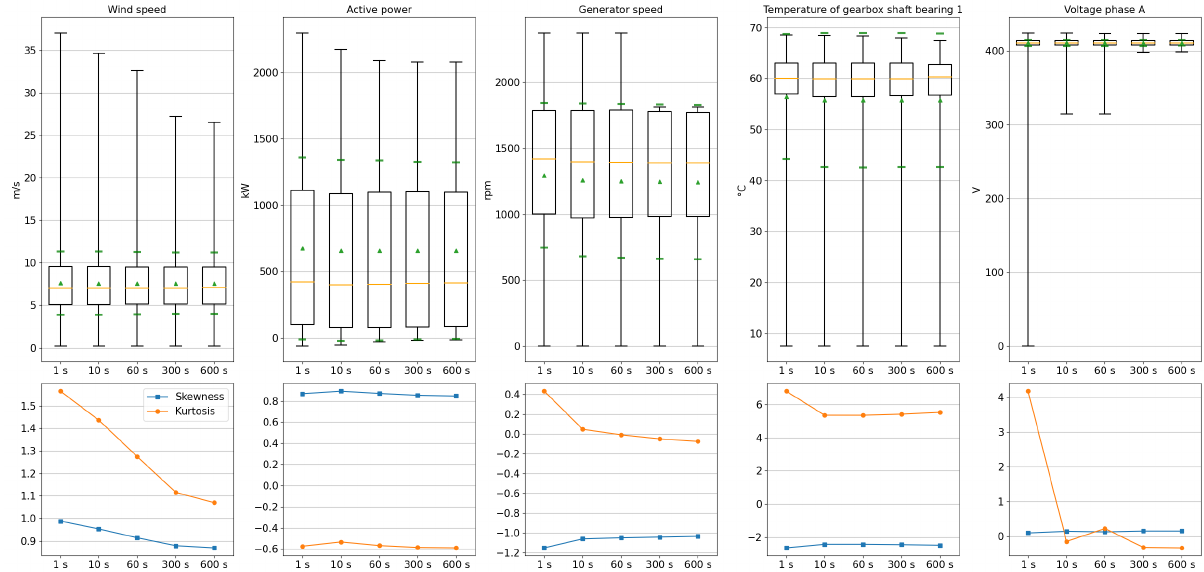
Figure 2. Illustration of the descriptive statistics of wind speed, active power generation, generator speed, temperature of gearbox shaft bearing 1, and voltage of phase A at different levels of temporal aggregation for wind turbine 5. On the top: box-and-whisker plots with the median depicted by the yellow bar, and the mean by the green triangles surrounded by ± the standard deviation as green bars. The black box displays the interquartile range, the black whiskers denote the maximum and minimum, including outliers. On the bottom: scatter plots of skewness and kurtosis normalized to standard deviation with interconnecting lines for better